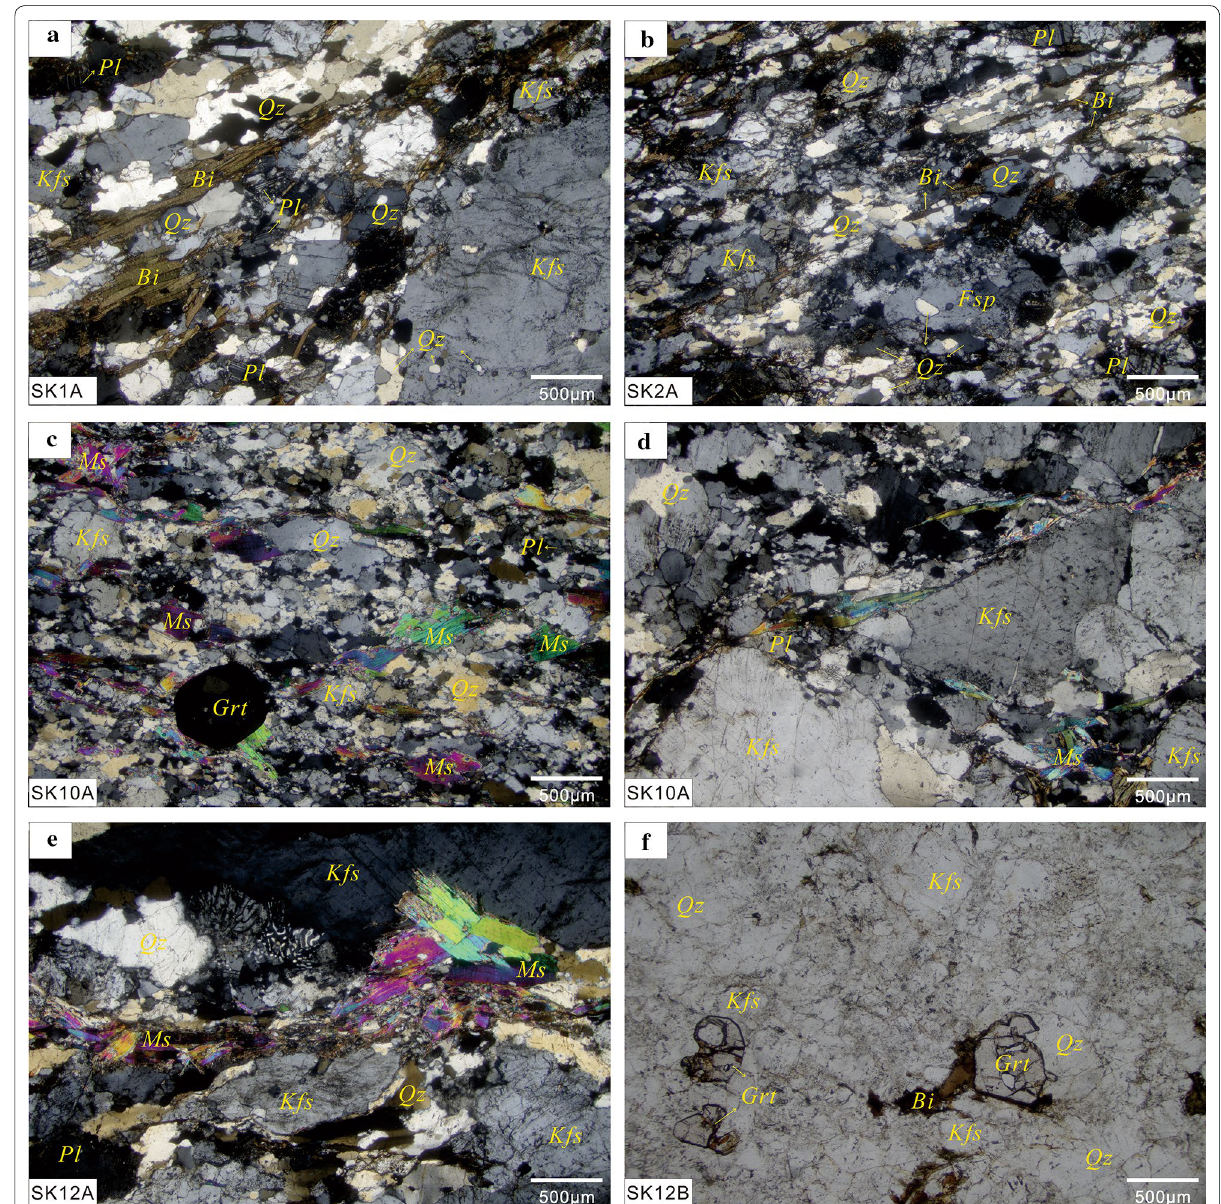
Fig. 4 Microstructures of augengneisses and leucogneiss from the Pohorje area. For explanation, see text. Images combined from microphotographs with both crossedand parallel (greyish photomicrographs) polarizers. Sample numbers in the lower left, scale in the lower right corner. Qz, quartz; Pl, plagioclase; Kfs, K-feldspar; Bt, biotite; Ms, white mica; Grt,